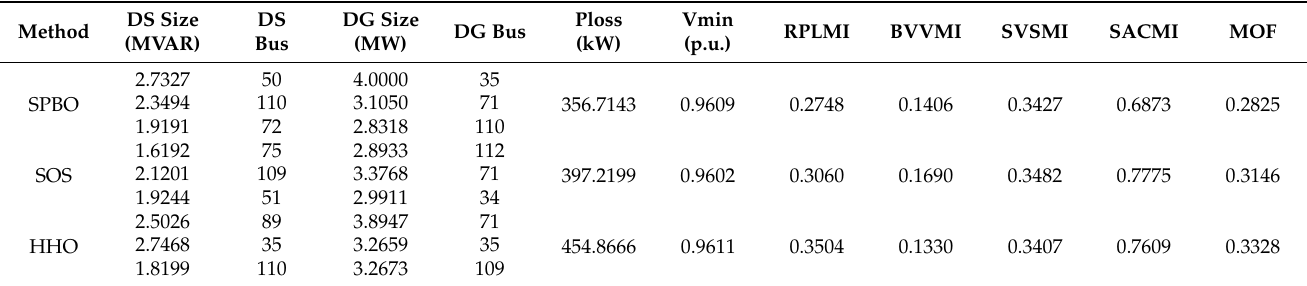
Table 10. Comparison of results for simultaneous DS and PV-DG allocation (case-5) for 118-bus test system.